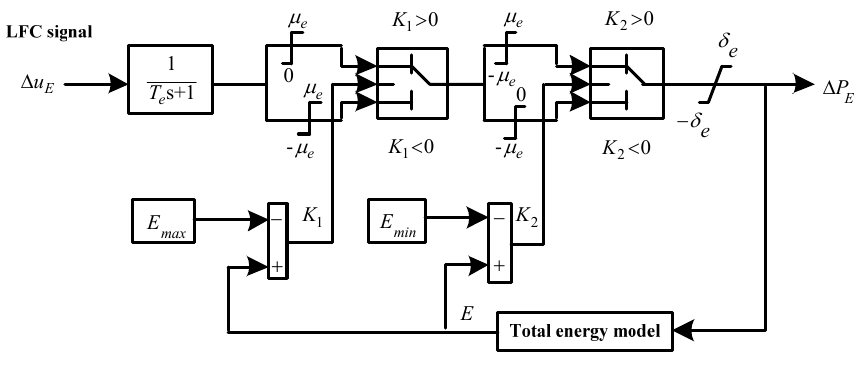
Figure 3. The equivalent EV model for LFC